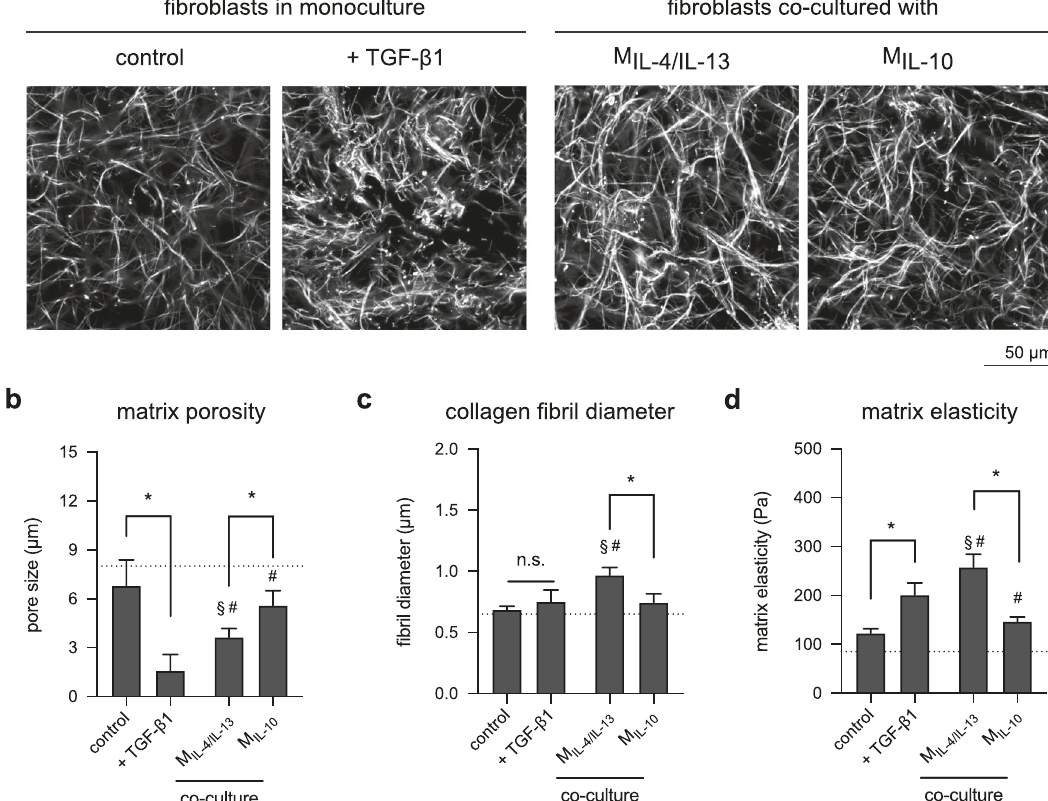
Fig. 5 Matrix remodeling by fi broblasts in the presence of TGF- β 1 and co-culture with M2 subtypes. a Representative images of decellularized collagen matrices in mono and co-culture with M2 subtypes (scale bar: 50 μ m). Decellularized collagen matrices were characterized regarding b matrix porosity characterized as mean pore size, c collagen fi bril diameter, and d bulk matrix elastic modulus (data are represented as mean ± SD; *signi fi cance level of p ≤ 0.05 using a one-way ANOVA followed by Tukey ’ s post hoc analysis). The characters # and § represent the signi fi cance level of p ≤ 0.05 using a one-way ANOVA followed by Tukey ’ s post hoc analysis when compared to control, and treated samples with TGF- β 1, respectively. For the quanti fi cation of matrix porosity and collagen fi bril diameter, 10 different positions of each matrix condition were analyzed. Experiments were performed in four